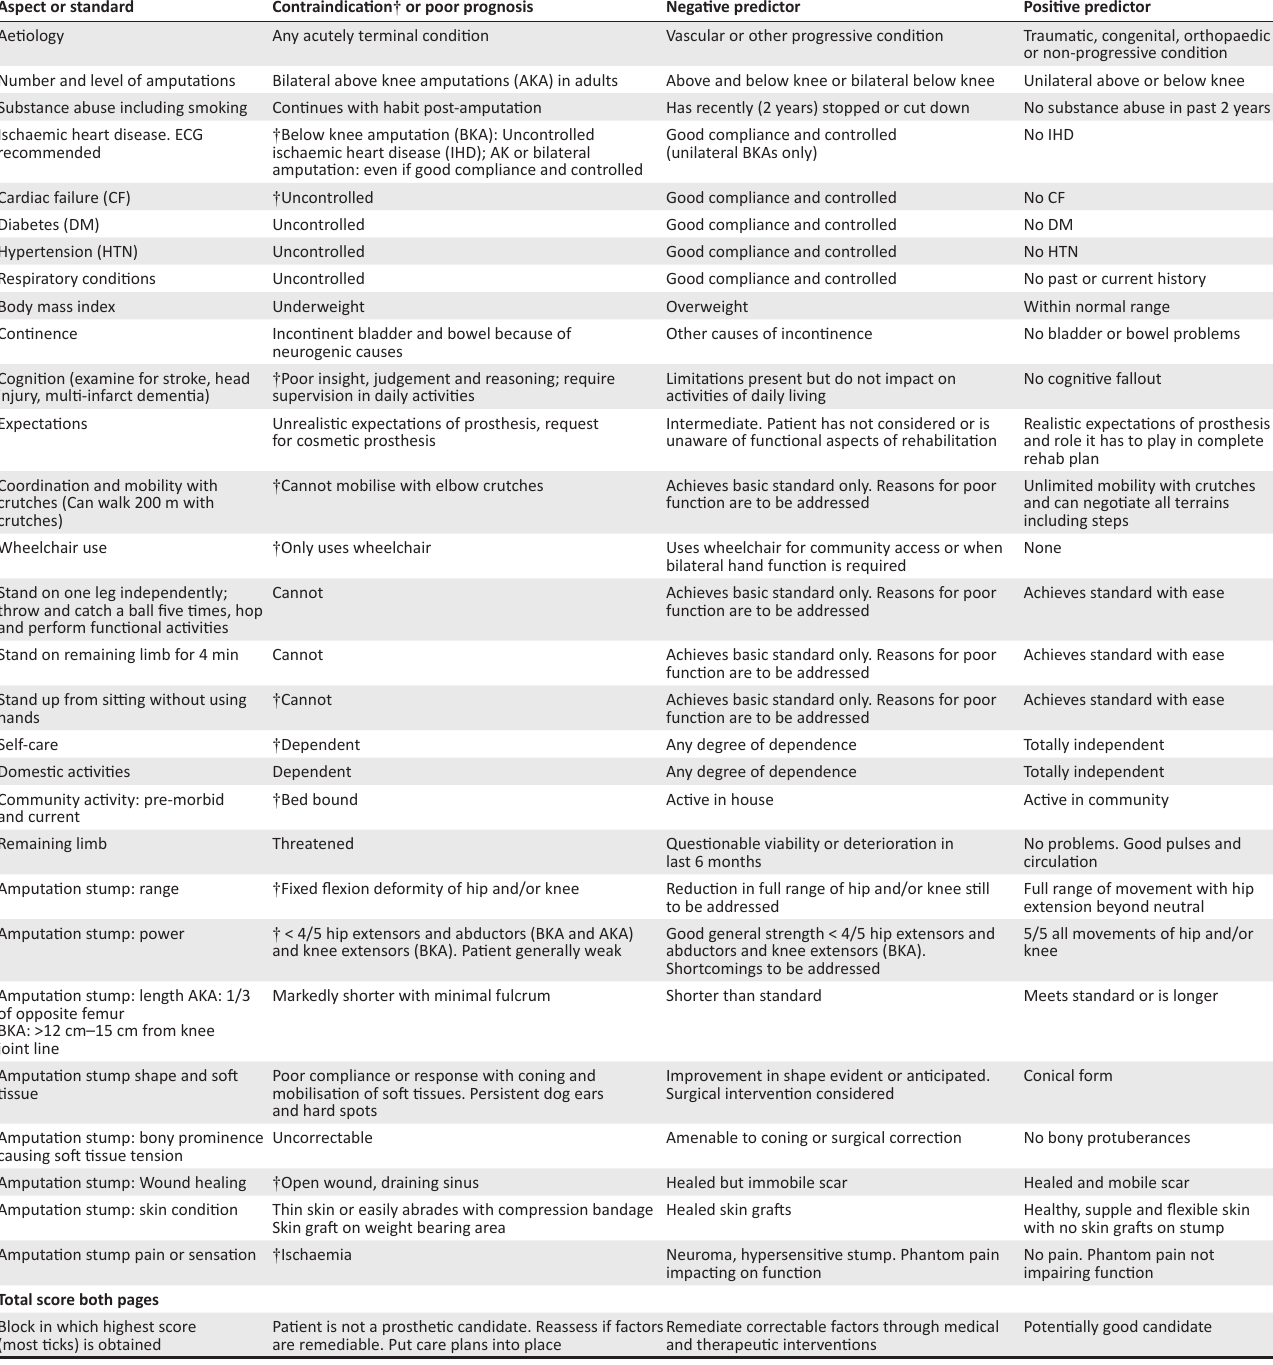
TABLE A1: The layout and contents of the tool. Aspect or